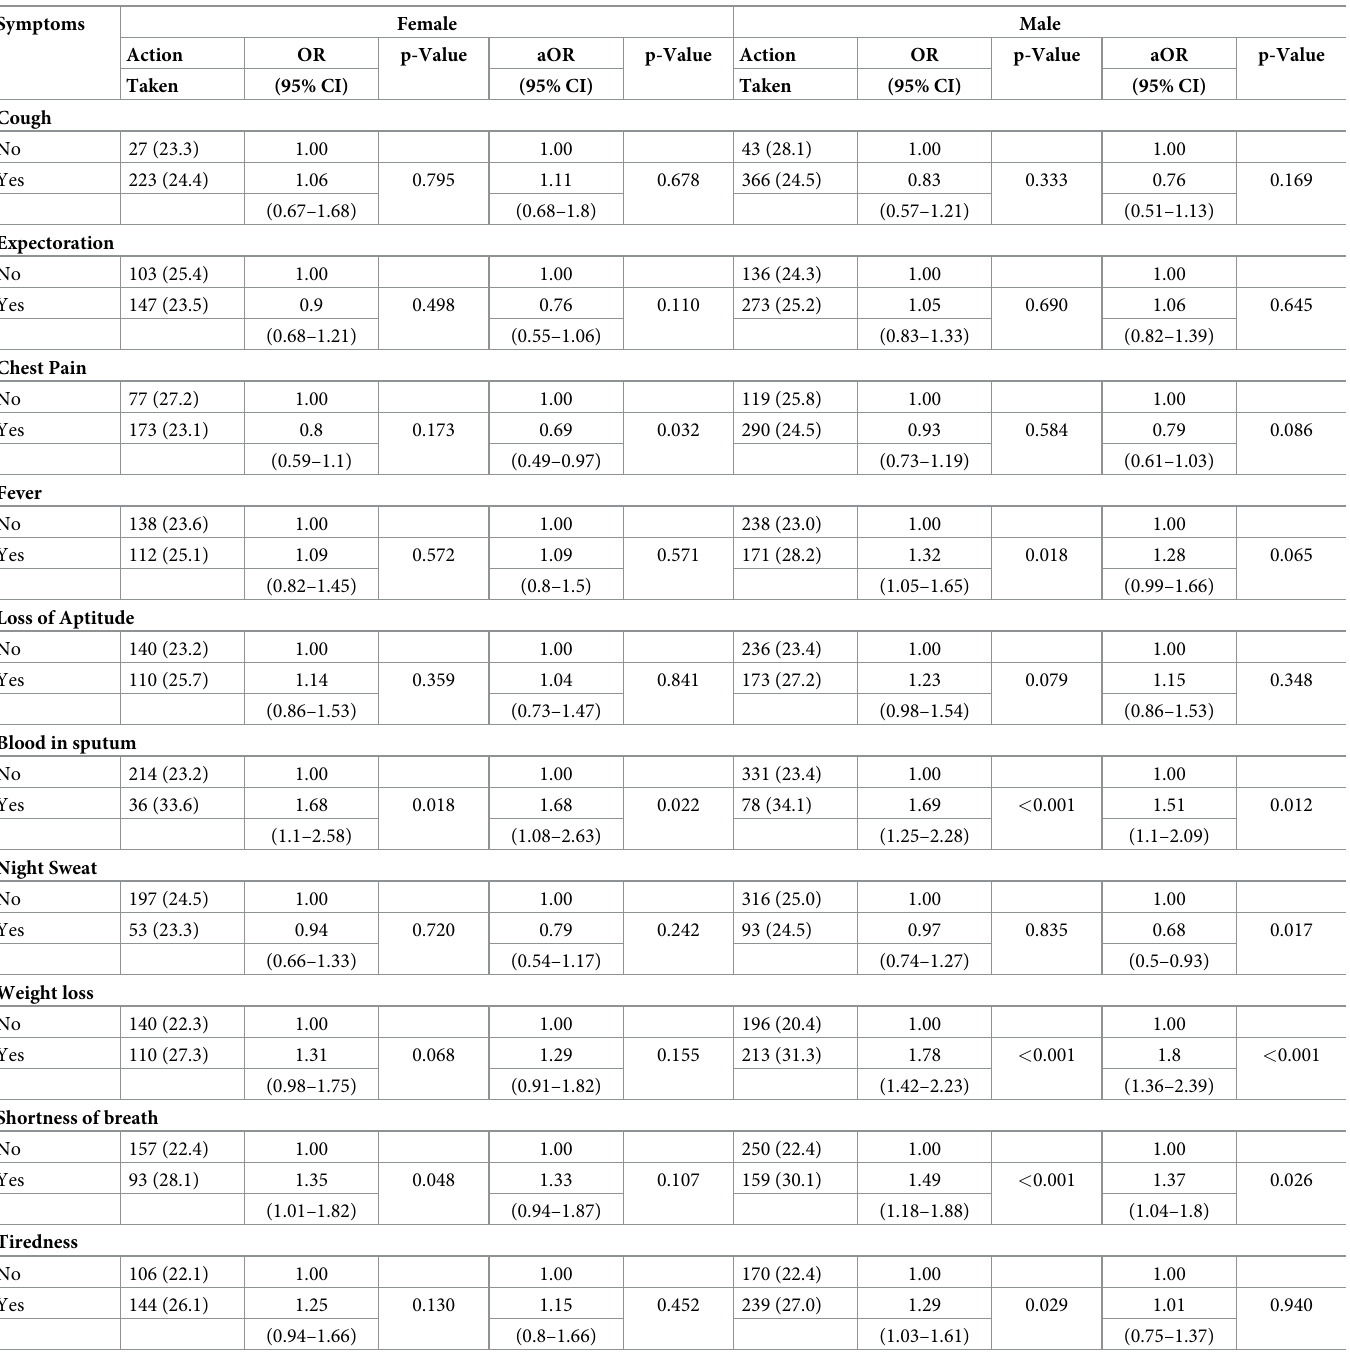
Table 3. Symptoms influencing persons with presumptive TB to seek care by